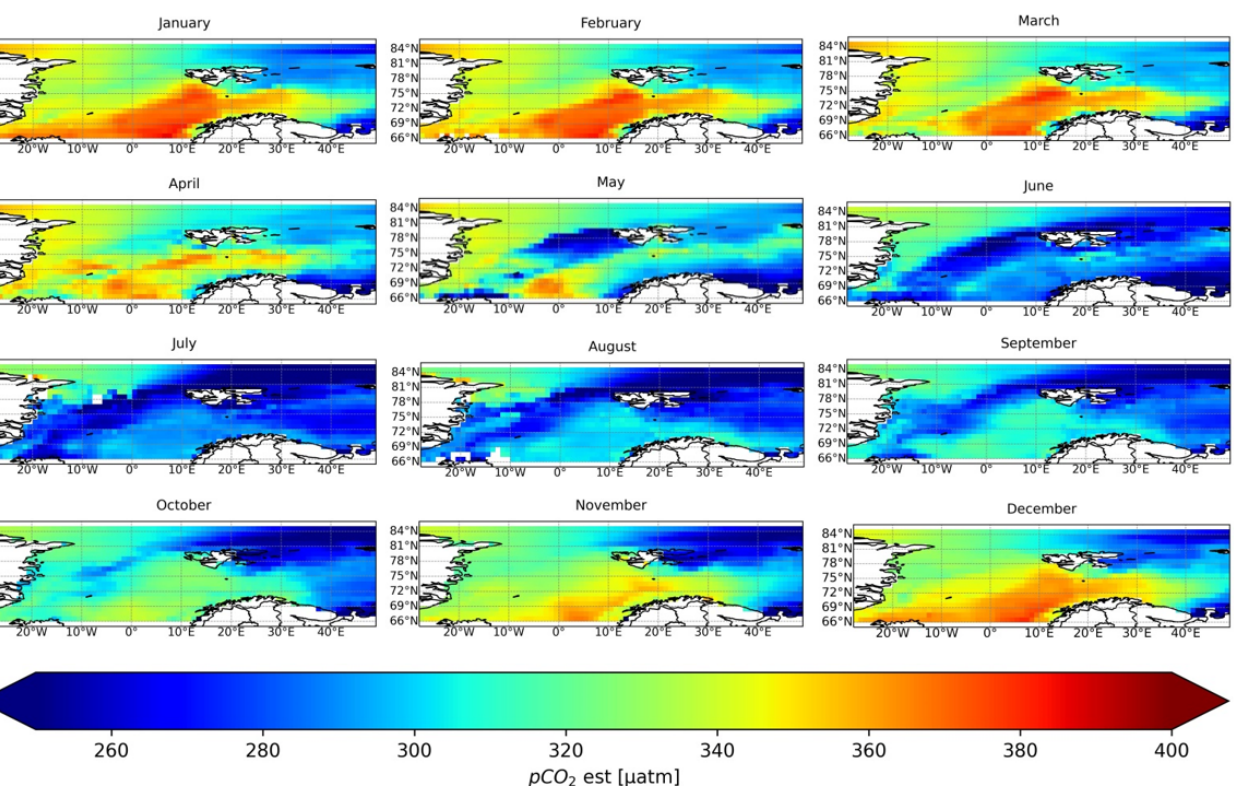
2W in the European Arctic